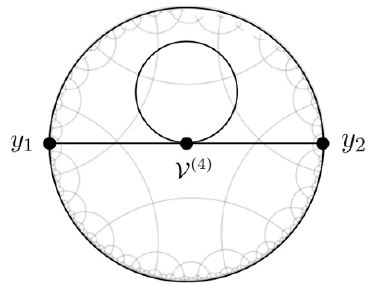
Figure 3. Scalar two-point one-loop tadpole diagram generated by the quartic interaction V (4)